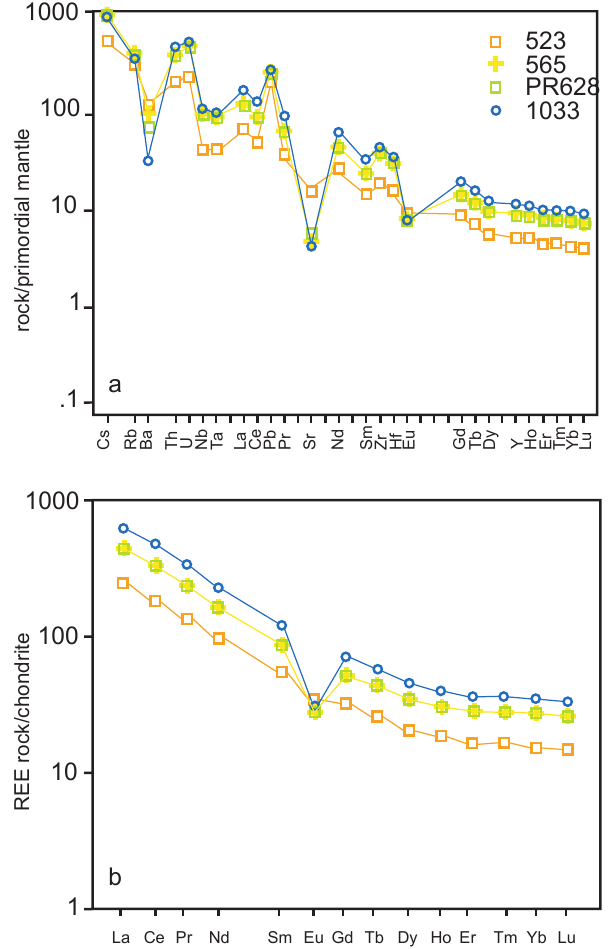
Fig. 5. (a) Primitivemantle-normalised incompatible elements di- agram and (b) chondrite-normalised rare earth element (REE) dia- gram for the selected samples. Samples 523, 535 and 1033 are from core Co1202, the sample PR628 is from core